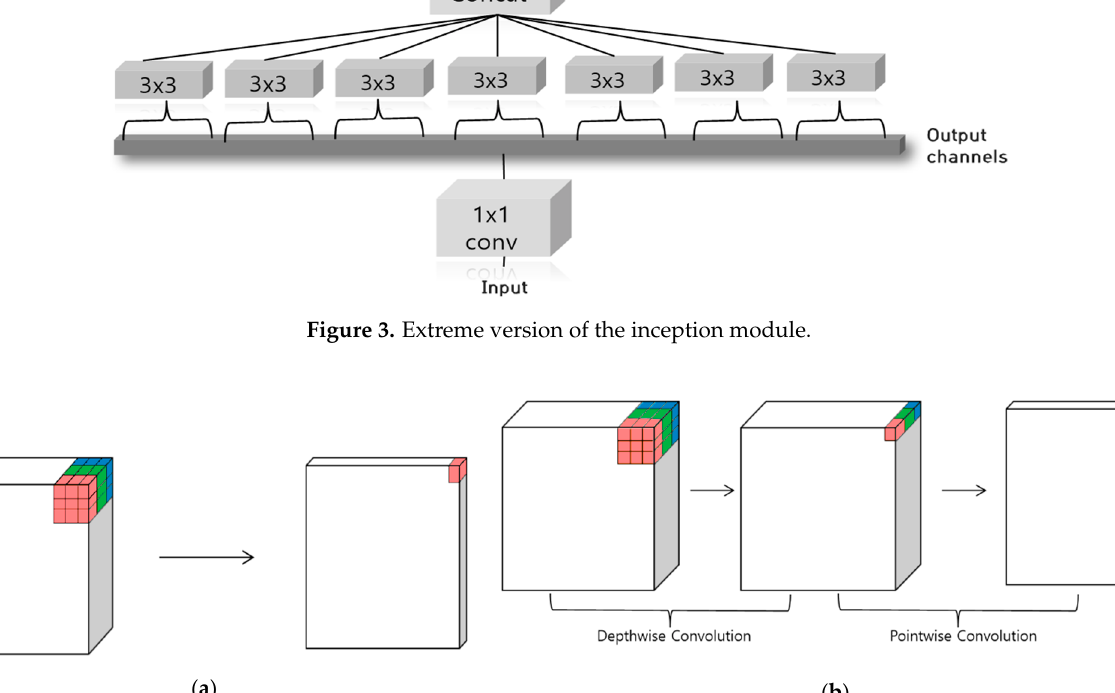
Figure 4. Types of convolution: ( a ) standard convolution and ( b ) depth-wise separable convolution.